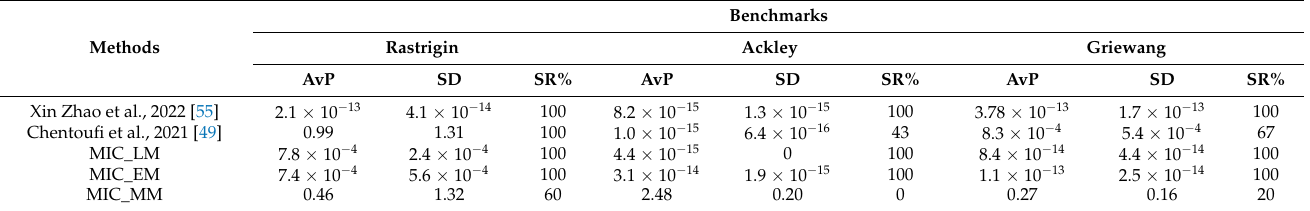
Table 4. Comparison with Other Published Methods in 30D. N/A means not